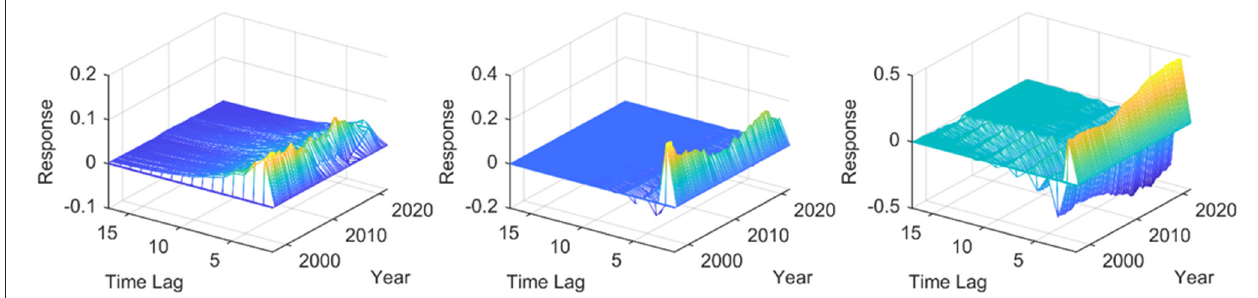
FIGURE 2 | Three-dimensional impulse responses of quantitative monetary policy acting on different economic zones in mainland China. The three sub graphs represent the impulse responses of the primary, secondary, and tertiary industries from left to right, respectively. One period in the figure denotes one